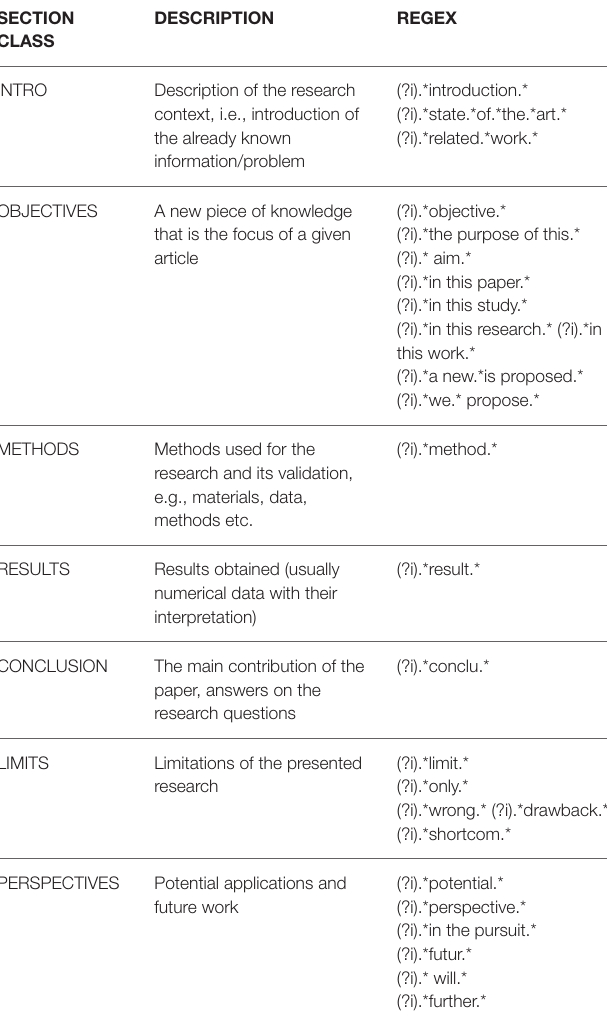
TABLE 2 | Regular expressions used for section